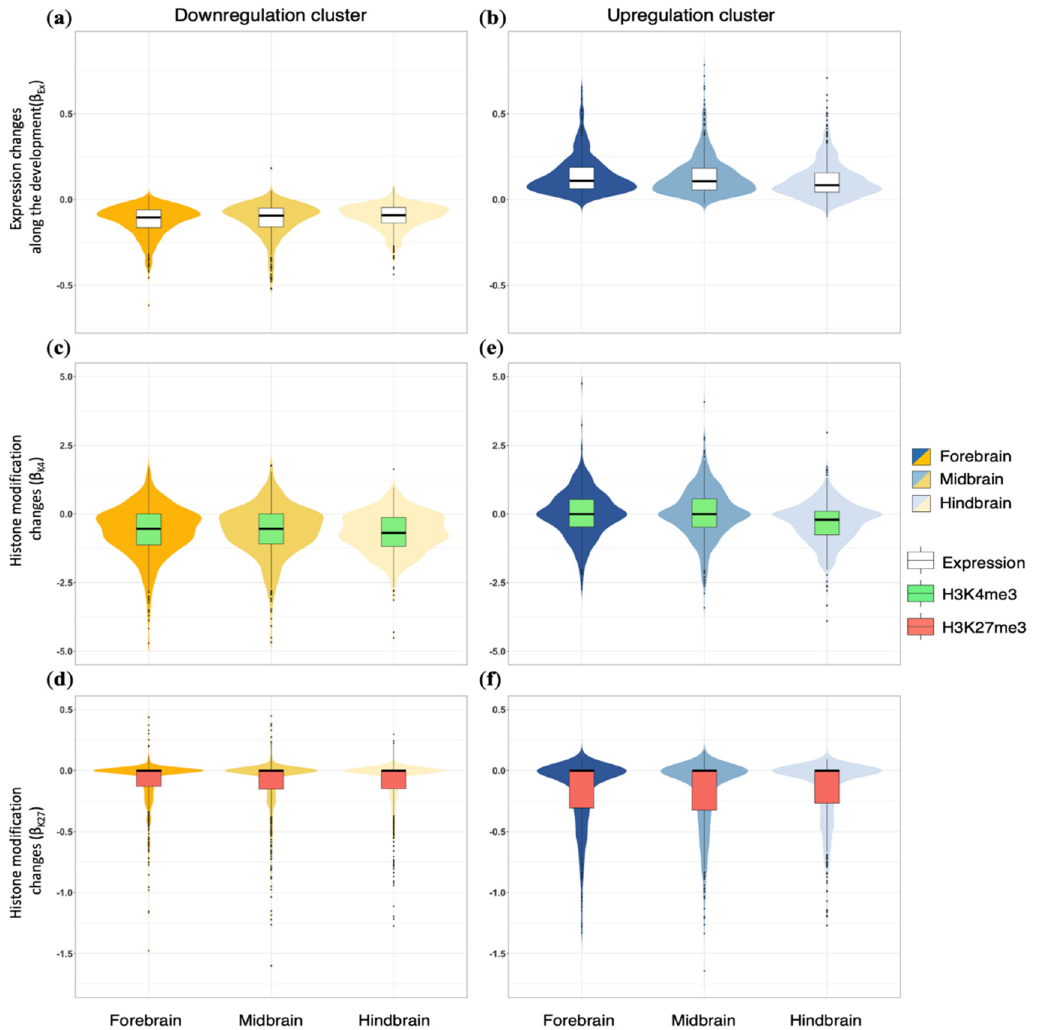
Figure 4. Distinct histone modifications are responsible for the chronical change in expression of the downregulation and upregulation clusters. Regression coefficients ( β Ex ) between mRNA expression and ages for the downregulation clusters ( a ) and the upregulation clusters ( b ) in the forebrain, midbrain, and hindbrain. Regression coefficients ( β K4 ) between H3K4me3 signals and ages for genes in the downregulation clusters ( c ) and the upregulation clusters ( d ) in the forebrain, midbrain, and hindbrain. Regression coefficients ( β K27 ) between H3K27me3 signals and ages for genes in the downregulation clusters ( e ) and the upregulation clusters ( f ) in the forebrain, midbrain, and hindbrain. All three brain regions show consistent patterns.